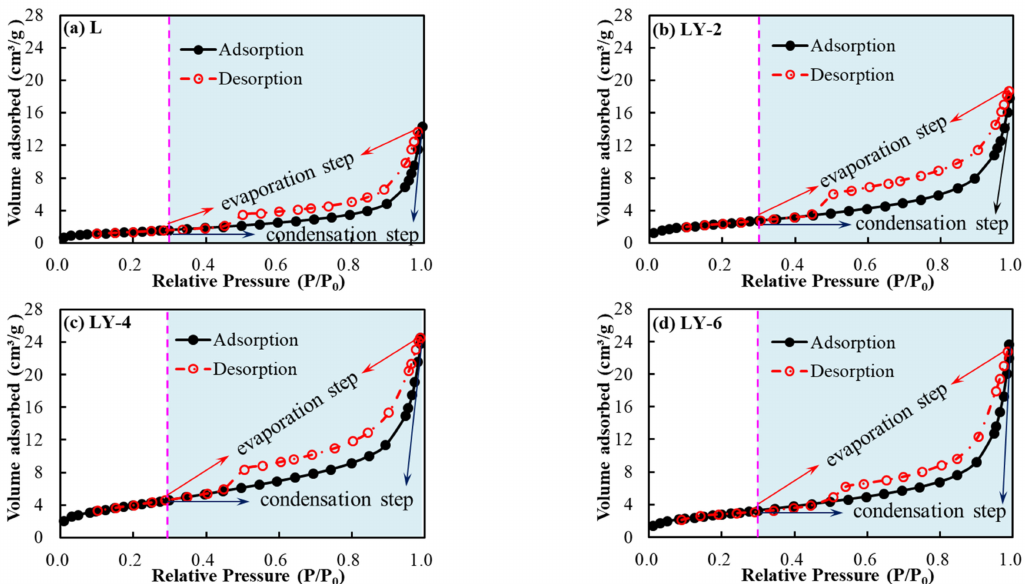
Figure 9. Low-temperature liquid N 2 adsorption/desorption results from specimens in L and LY groups: ( a ) L; ( b ) LY-2; ( c ) LY-4; ( d ) LY-6.